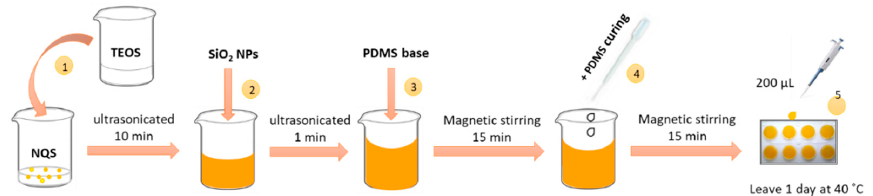
Figure 1. Steps of the sol-gel process that takes place for the sensor preparation.